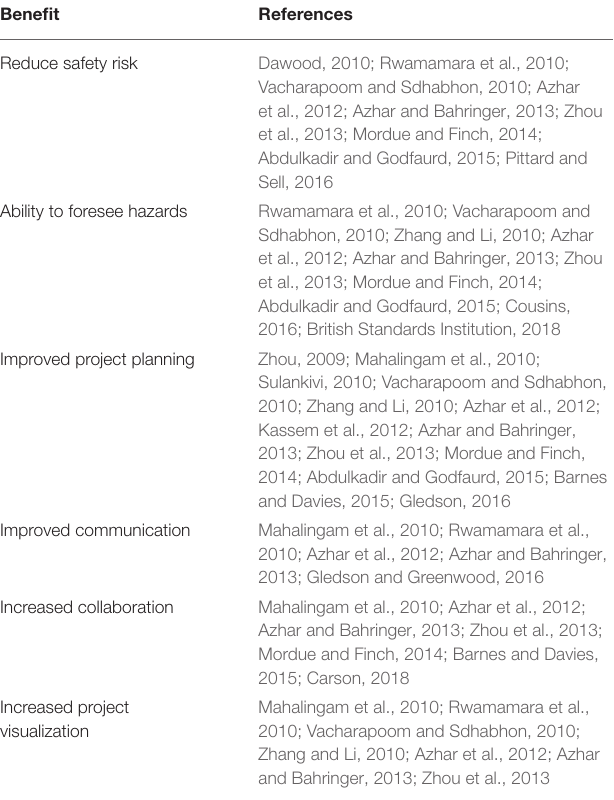
TABLE 1 | Summary of the benefits of 4D in relation to health and safety management.